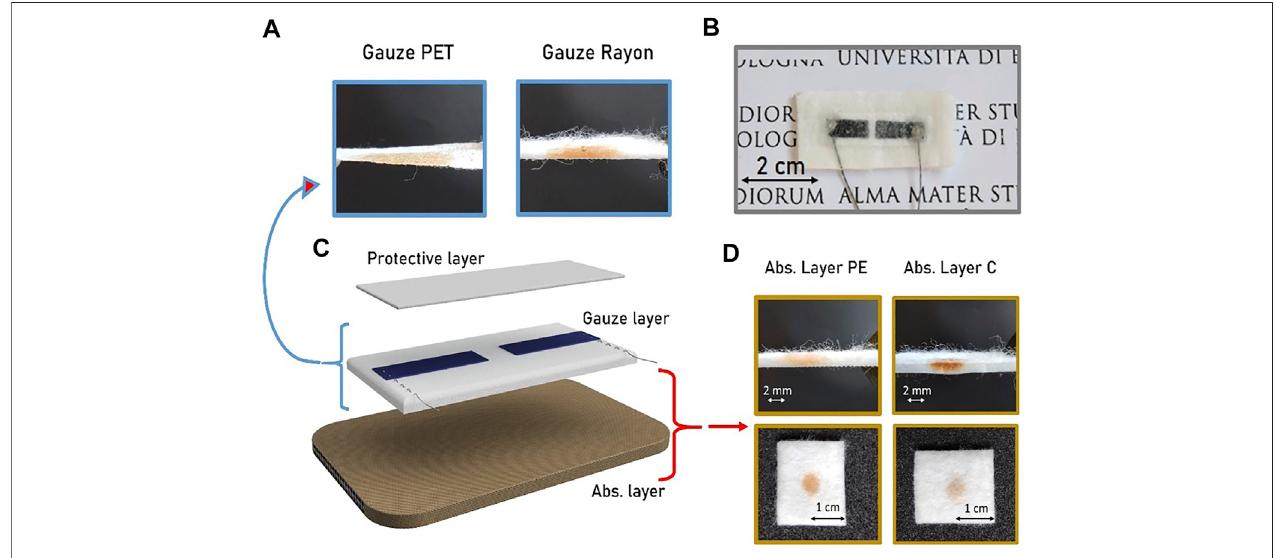
FIGURE3| Complete moisturesensorsarchitecture. (A) Crosssection oftheGauzesPET andRayon withthediffusionpro fi leofacoloreddrop. (B) Opticalimage of the fi nal textile moisture sensor prototype. (C) Structure of the bandage sensor showing the three different composition layers. (D) Cross section and top views of the two absorbing layers used as reservoir substrate highlighting their different wettability.